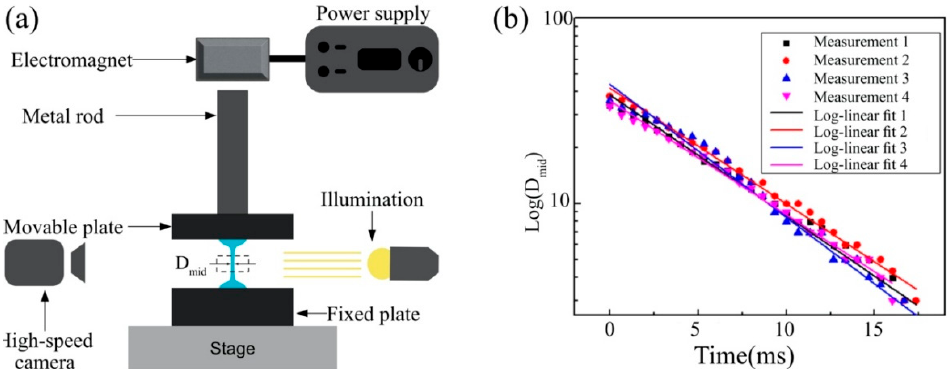
Figure 1. ( a ) Schematic of the filament break-up experiment. ( b ) An example of the determination of the relaxation time λ 1 based on the log-linear fit, log(D mid ) ∝ ( − t/(3 λ 1 )), where PVB B-72 in benzyl alcohol with a concentration of 4 g/dL was used. Four measurements of the same solution on the same set-up were performed to find an average relaxation time.